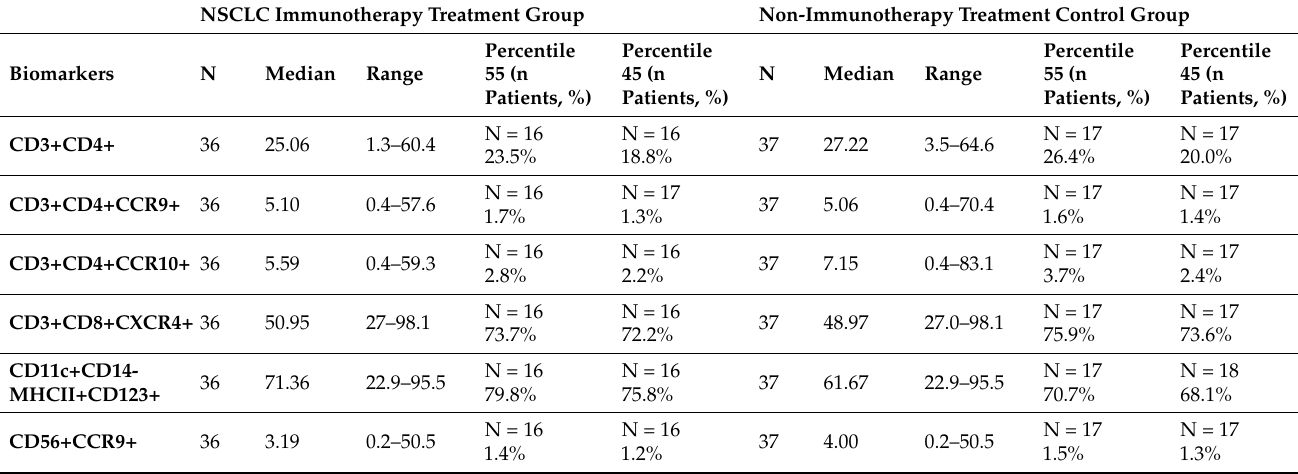
Table 3. Description of the best immune subpopulations biomarkers in the overall survival